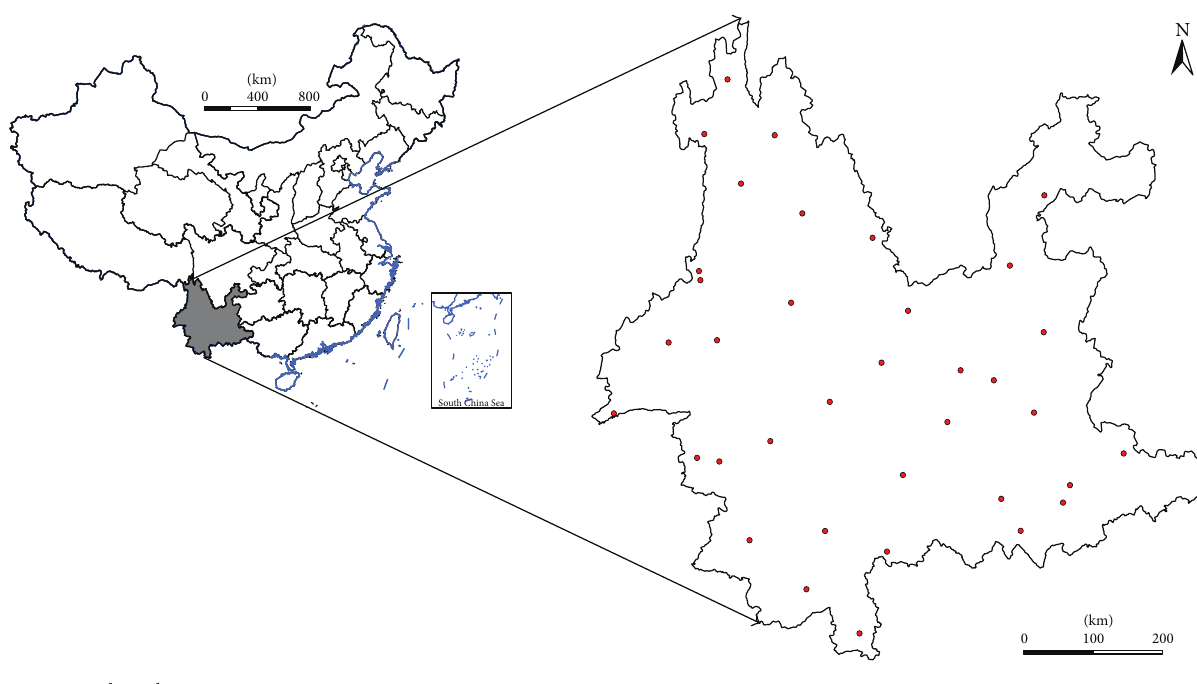
Figure 1: Study area and the distribution of meteorological stations in Yunnan